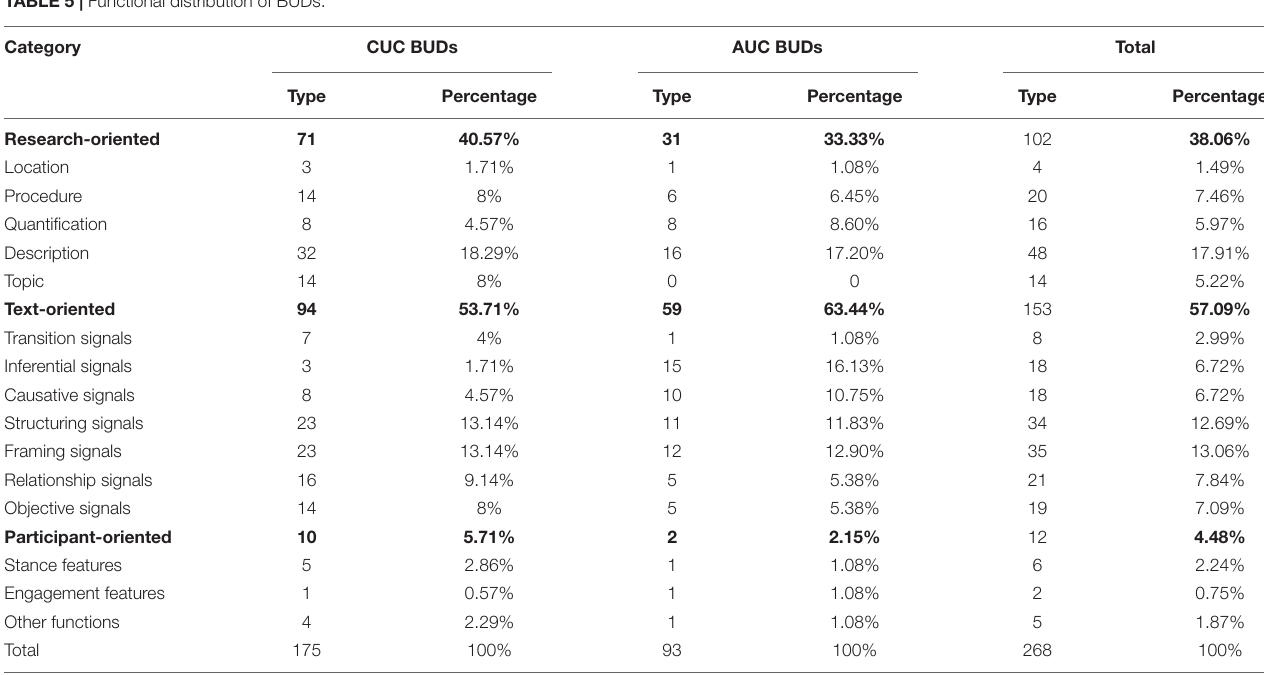
TABLE 5 | Functional distribution of BUDs.